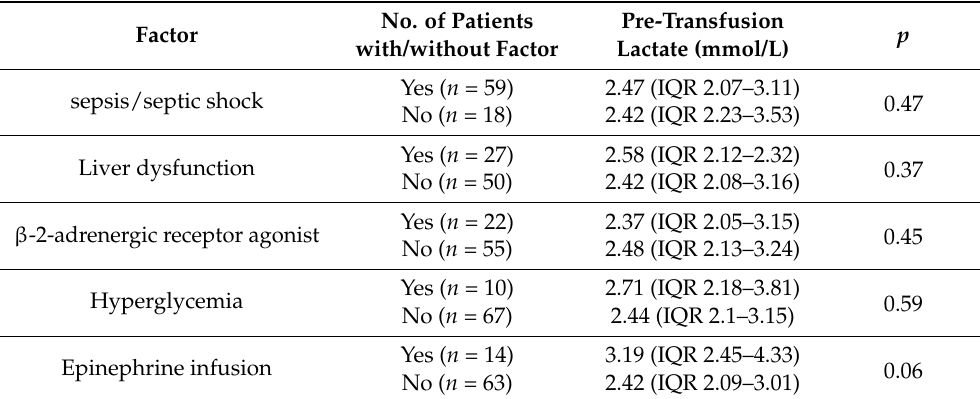
Table 2. Intergroup differences in pre-transfusion lactate concentration in patients with and without factors potentially affecting lactate concentration. IQR—interquartile range.